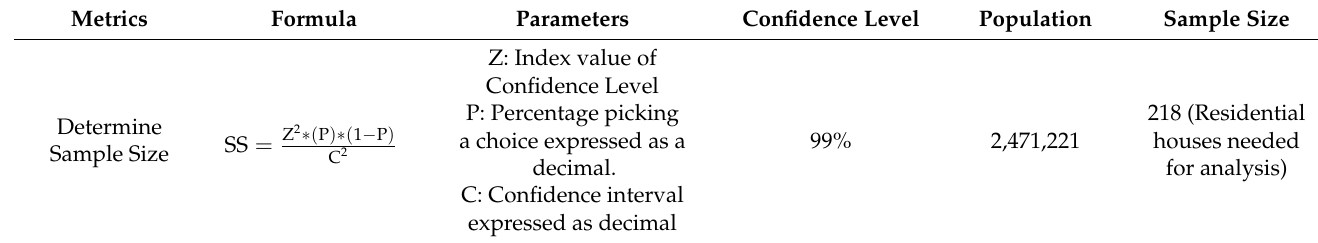
Table 2. Sample Size of Residential Houses [46].